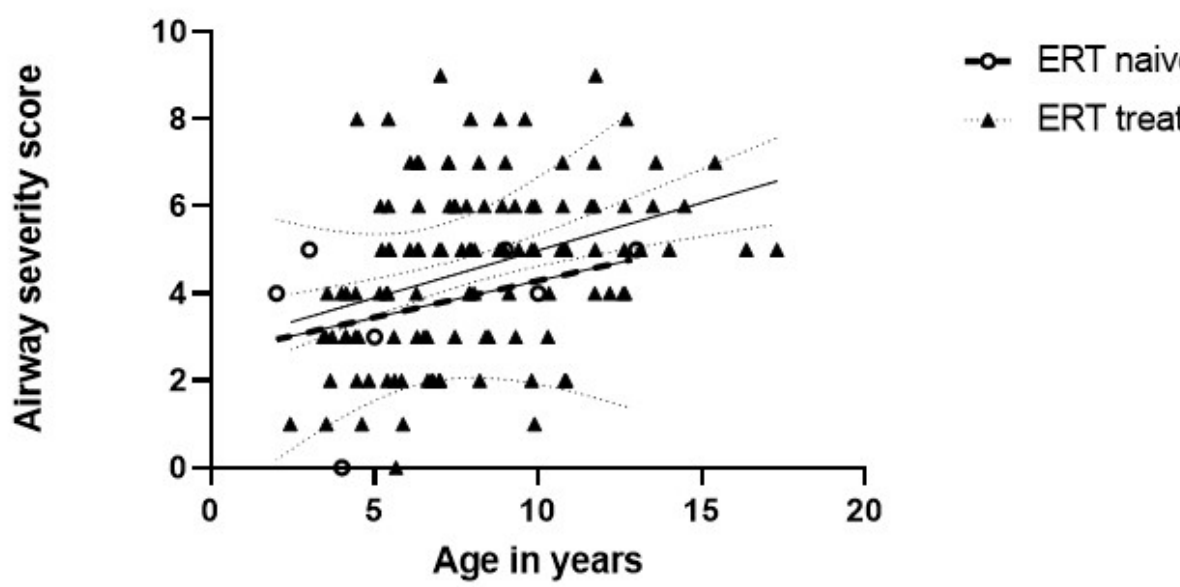
Figure 2. Linear model fitted via generalized estimation equations (GEE) between average airway severity score and age, controlling for ERT group. One year increase in age leads to an expected increase of 0.25 (95% CI: 0.16, 0.33; p < 0.001) units in the airway severity score. The dotted lines represent 95% confidence intervals. Open circles are ERT naïve, and closed triangles are ERT treated individuals.